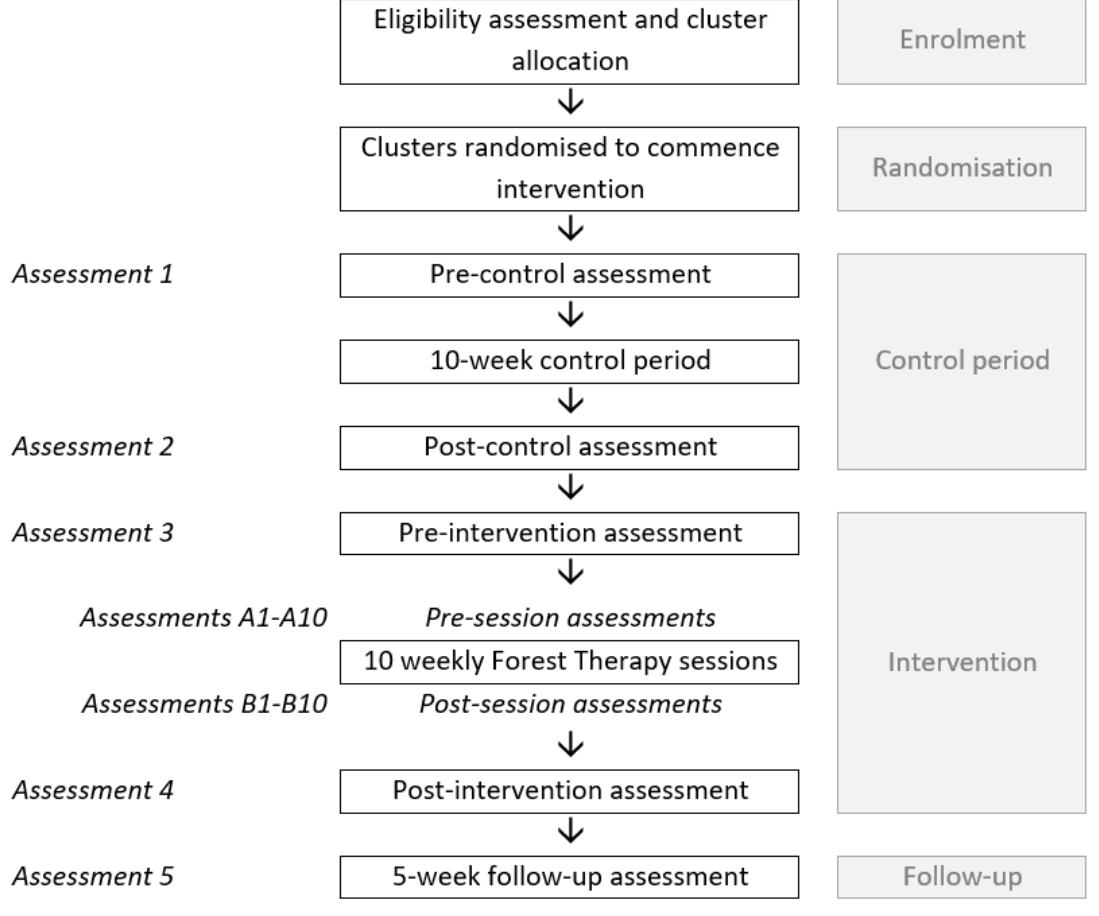
Figure 1. Study phases and assessment timepoints.